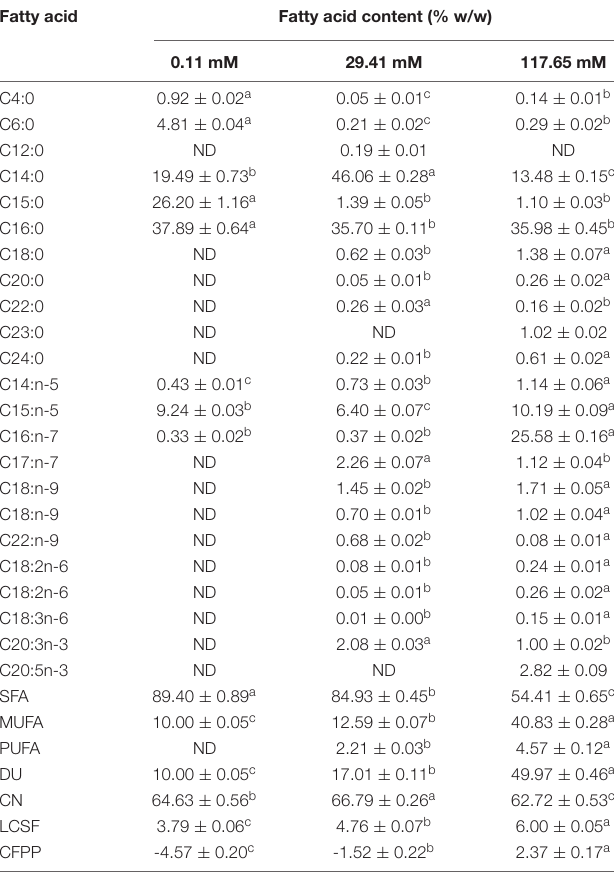
TABLE 2 | Effects of different nitrogen concentrations on the fatty acid profiles and biofuel quality of Nitzschia sp. NW129. Fatty acid Fatty acid content (%